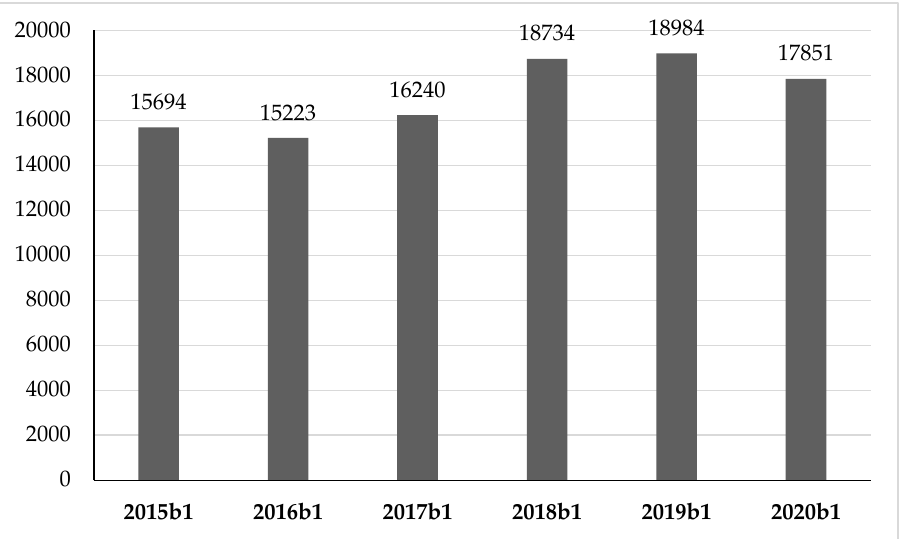
Figure 3. Number of EAN codes of 0.75 liter bottles sold.